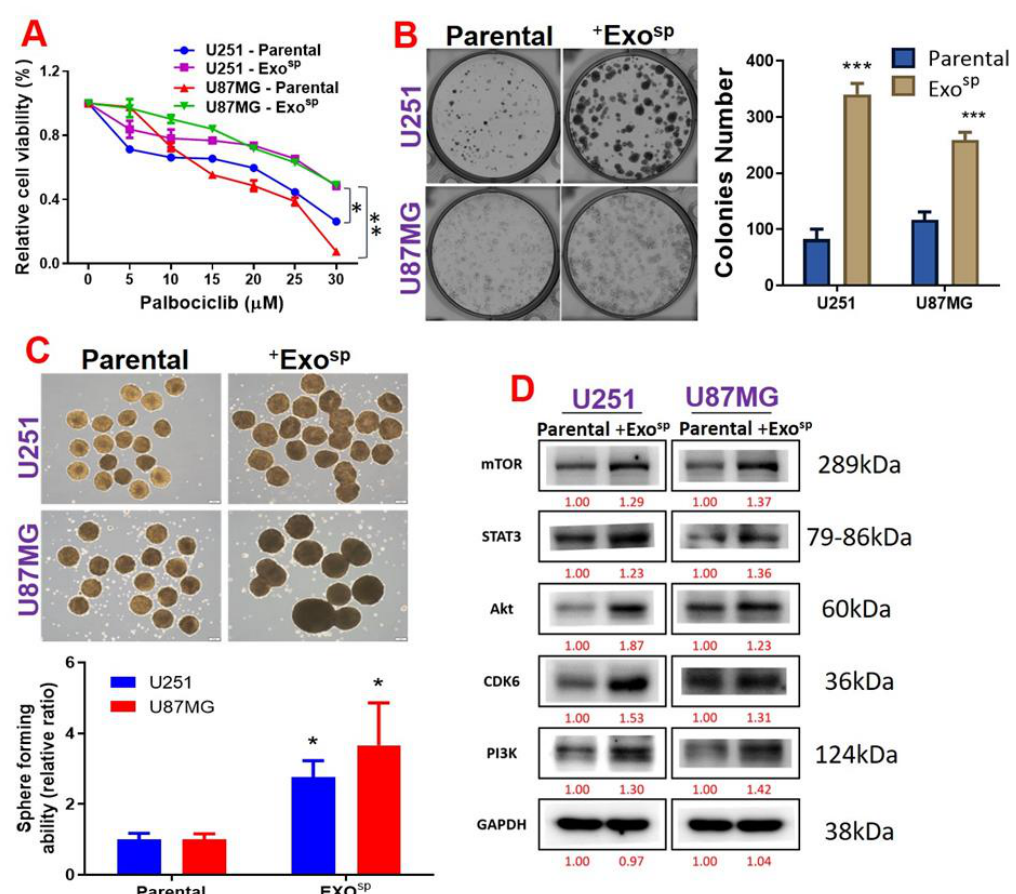
Figure 6. Tumorsphere-derived exosomes (Exo sp ) promoted the expression of mTOR, STAT3 and CDK6 expressions, palbociclib resistance, and tumorigenic properties of GBM cell lines. ( A ) Cell viability curve showing that U87MG and U251 cells co-cultured with Exo sp exhibited low sensitivity to palbociclib treatments compared to their parental counterparts. U87MG and U251 cells co-cultured with Exo sp also exhibited higher ( B ) colony forming ability, ( C ) sphere generating, and ( D ) expression levels of mTOR, STAT3, CDK6, Akt, and PI3K compared to their parental counterparts. Numbers in red indicate the relative expression ratio. * p < 0.05, ** p < 0.01, *** p < 0.001.